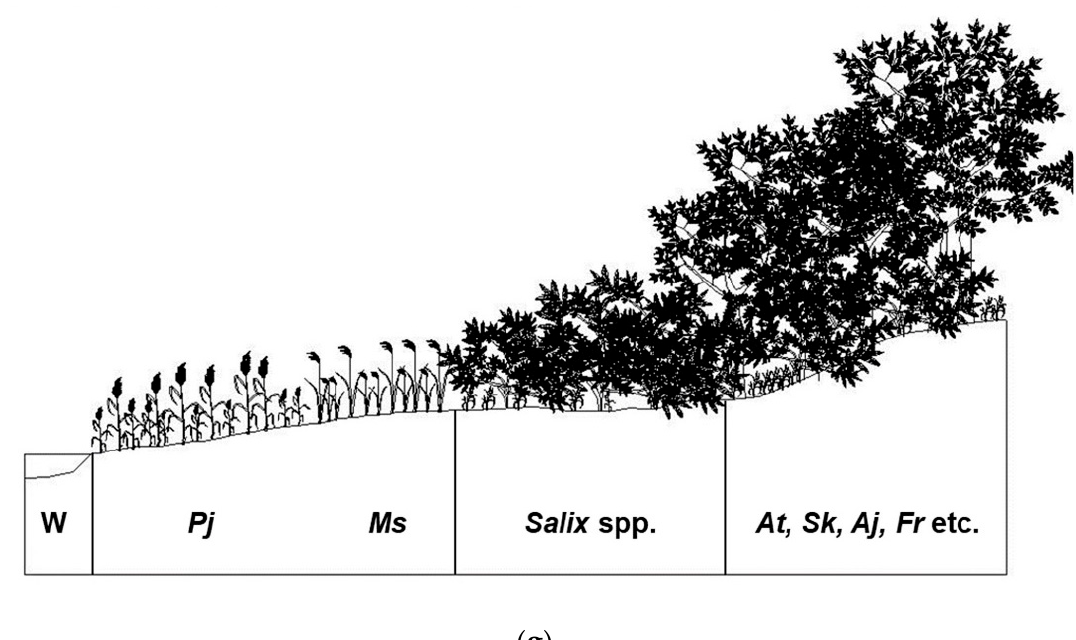
Figure 3. The reference information of the restored rivers and streams expressed as the stand profile. The reference information was collected from the Sami ( a ), Yudong ( b ), Miho ( c ), Yongsoo ( d ), Seomjin ( e ), Nakdong ( f ), and the Geum rivers ( g ). The reference rivers and streams were selected as the rivers and streams with a good conservation status as the rivers and streams belonging to the same watershed as the restored rivers and streams (Lim et al., 2021). Aj: Alnus japonica , At: Acer tataricum subsp. Ginnala, B: Bare ground, C : Carex spp., Fr : Fraxinus rhynchophylla , Jm : Juglans mandshurica , Ms : Miscanthus sacchariflorus